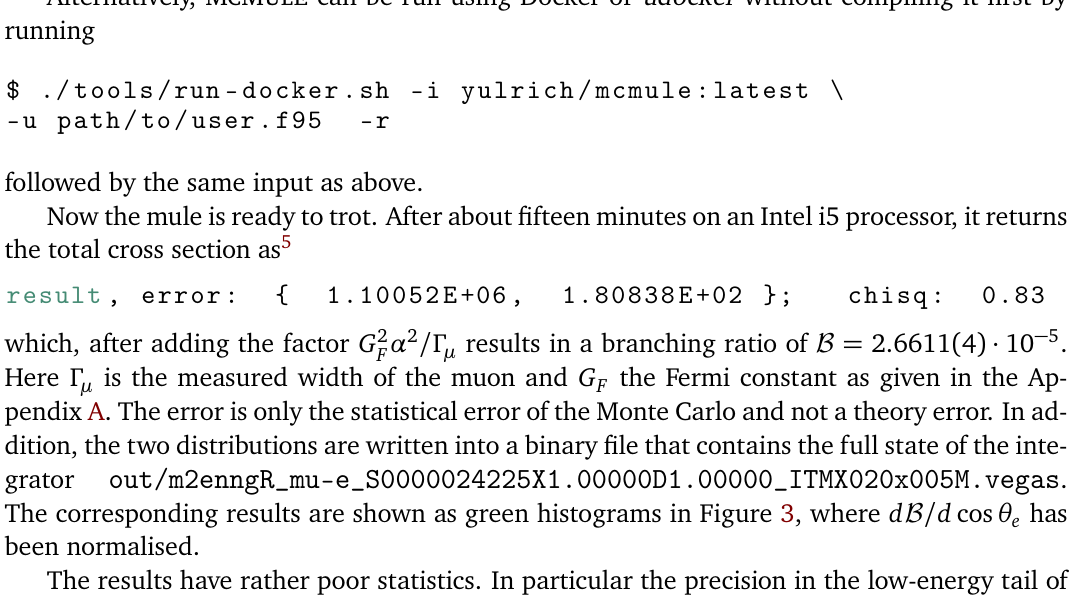
Figure 3: Results of a short test run for the branching ratio at LO for the double radiative muon decay µ → e ν ¯ νγγ , as a function of the missing energy and the angle of the outgoing positron. For the region / E < 20 MeV a tailored run is shown in yellow. of the NLO and NNLO run for muon-electron scattering. We also ignore the optional input for the